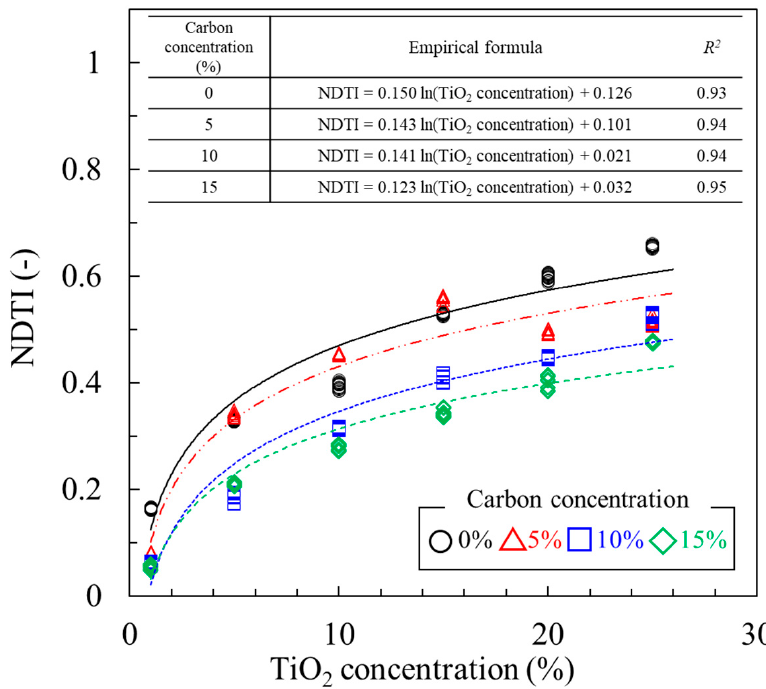
Figure 8. Scatter plots of TiO 2 concentration (%) versus NDTI for different carbon levels.